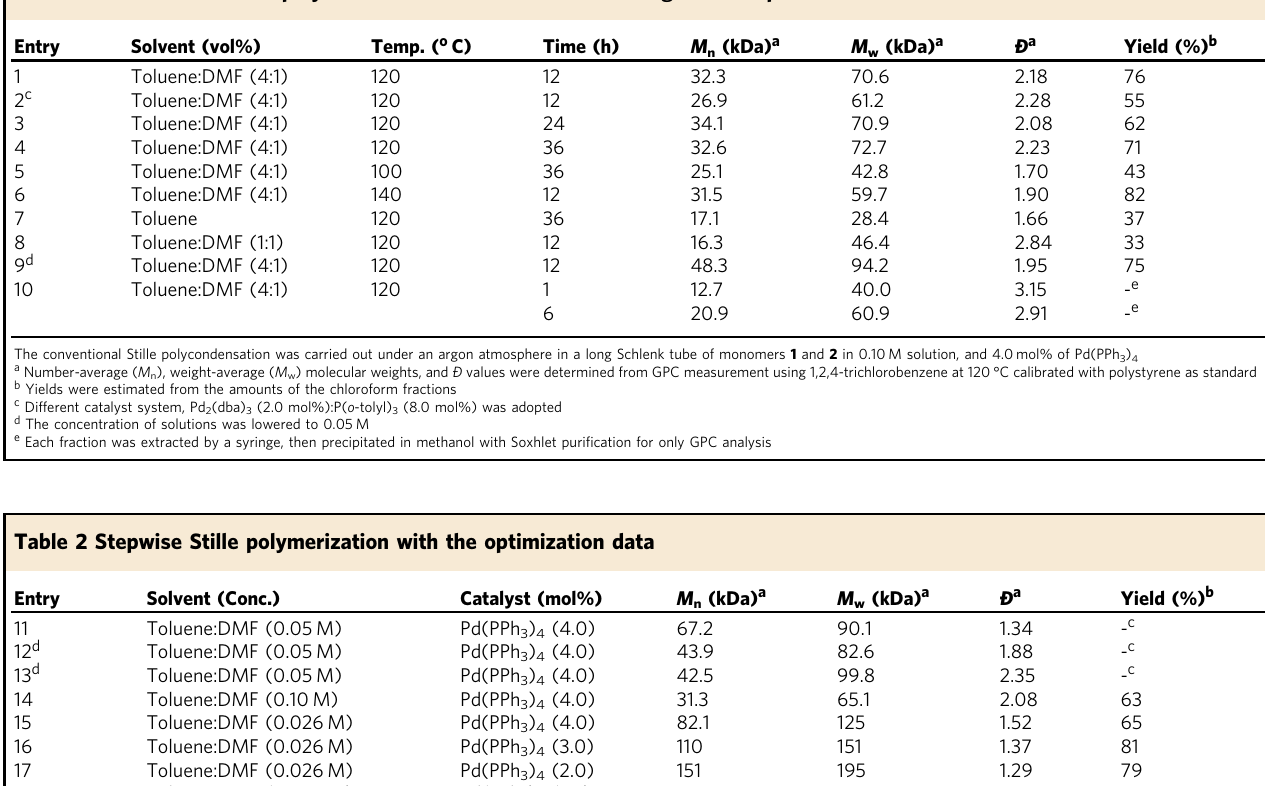
Table 1 Conventional Stille polymerization of PTB7 under screening reaction